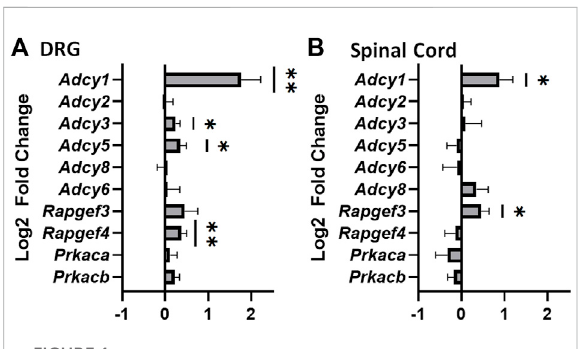
FIGURE 1 Signi fi cant increase in mRNA of adenylyl cyclase 1 in the dorsal root ganglia and spinal cords of mice that have undergone chronic morphine administration. Mice were given systemic morphine or saline twice daily for 5 days (15 mg/kg, sc). (A) Dorsal root ganglia (DRG) from morphine treated mice have elevated levels of Adcy1, Adcy3, Adcy5, and Rapgef4 mRNA compared to saline treated mice (one-sample t -test, n = 11 – 12/ group). (B) Spinalcordsfrommorphinetreatedmicehaveelevated levels of Adcy1 and Rapgef3 mRNA compared to saline treated mice (one-sample t -test, n = 14/group). Data are displayed as the Log2 fold change of morphine treated mice over the average of the saline treatment group, ±SEM,* p < 0.05, ** p <